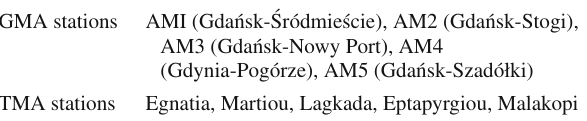
Table1 The Air Quality monitoring stations used for the current study in GMA and TMA GMA